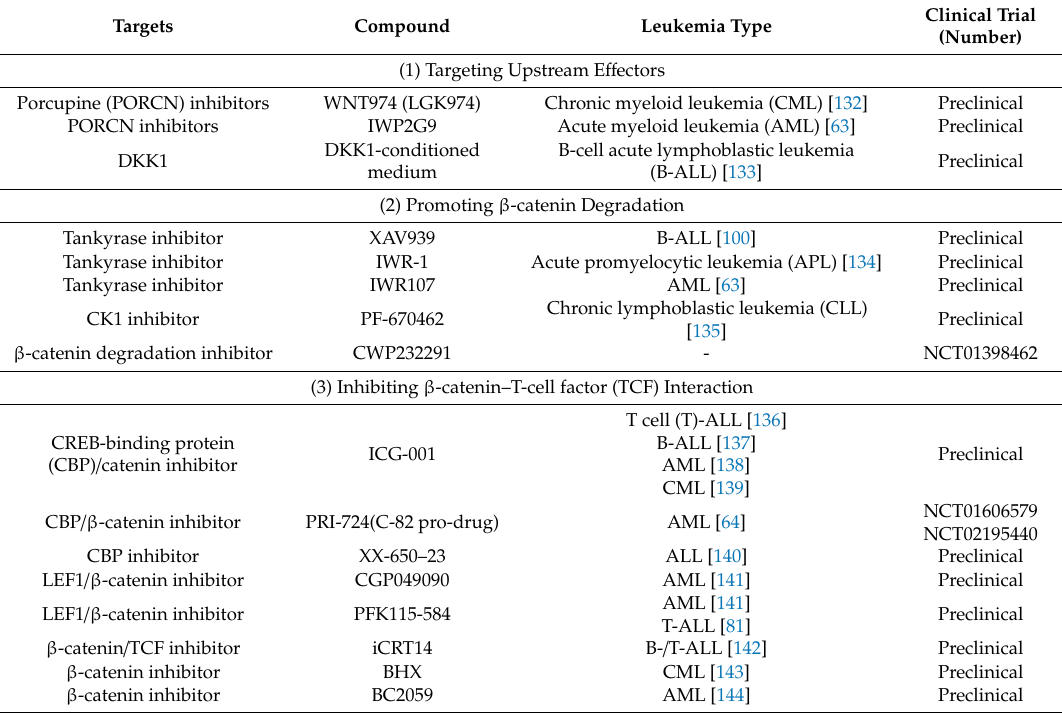
Table 1. Preclinical / Clinical Wnt– β -catenin Signaling Inhibitors in Leukemia.